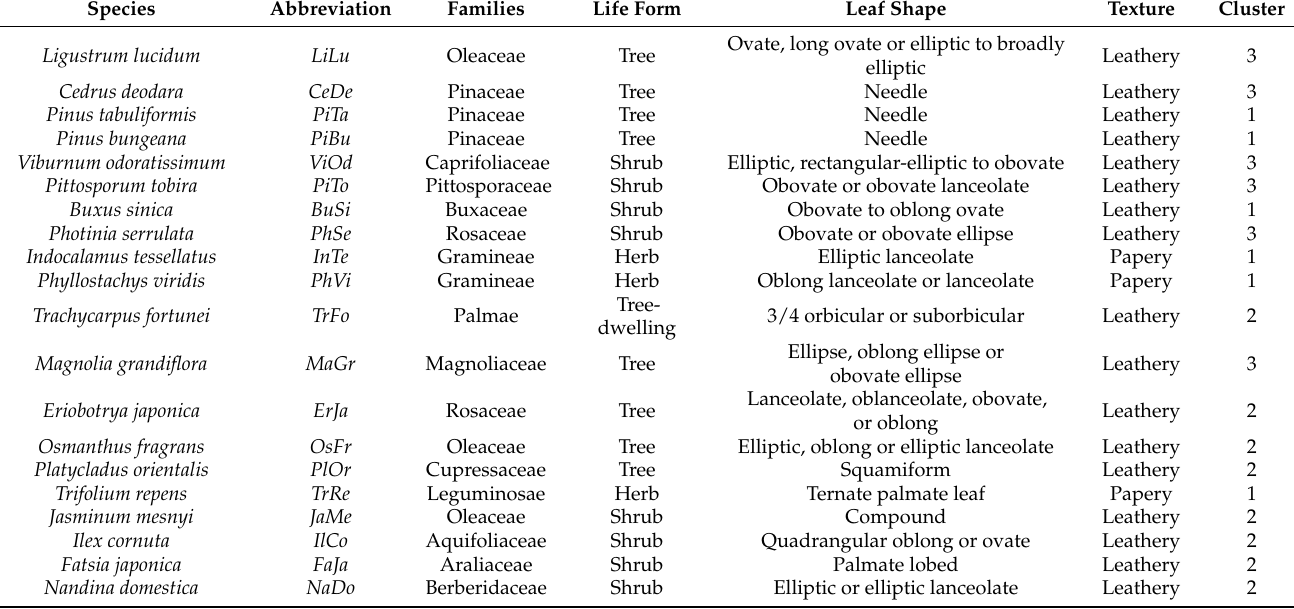
Table 3. Families, life forms, leaf shapes, and texture of the investigated plant species. The results from the clustering analysis with surface and wax dissolved fractions of PM >10 , PM 2.5–10 , PM 0.1–2.5 , water-soluble and organic-soluble PM and total PM as variables. Cluster 1 had the smallest quantity of deposited PM, and cluster 3 had the